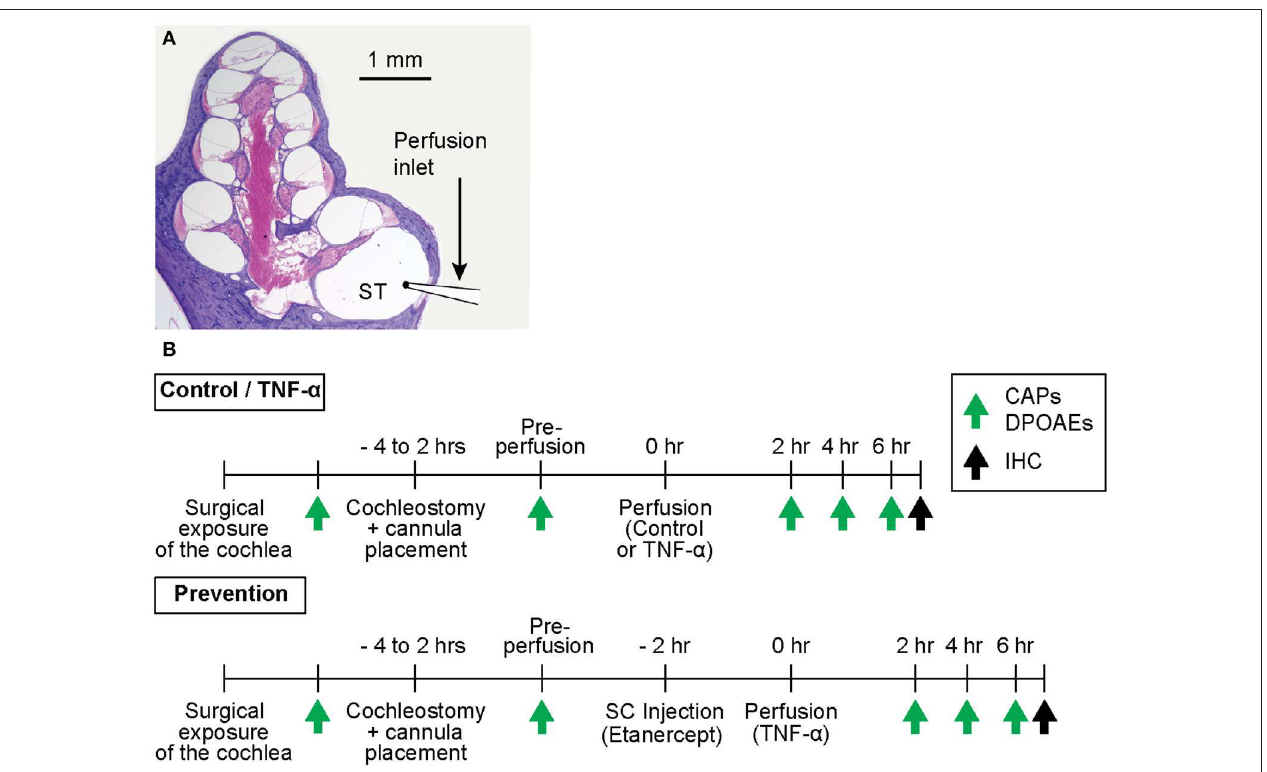
FIGURE 1 | (A) Mid-modiolar cross-section through a hematoxylin and eosin (H&E)-stained guinea pig cochlea, depicting its four spiraling turns. The microcannula is positioned through a cochleostomy adjacent to the round window to enable slow cochlear perfusion through scala tympani (ST). (B) Experimental timelines for control and TNF- α experiments vs. prevention experiments. The timelines are identical aside from the subcutaneous (SC) injection of a TNF- α -blocker (etanercept) prior to perfusion of TNF- α in prevention experiments. Green arrows indicate time points of hearing tests (CAPs and DPOAEs), black arrows indicate time point of post mortem immunohistochemistry